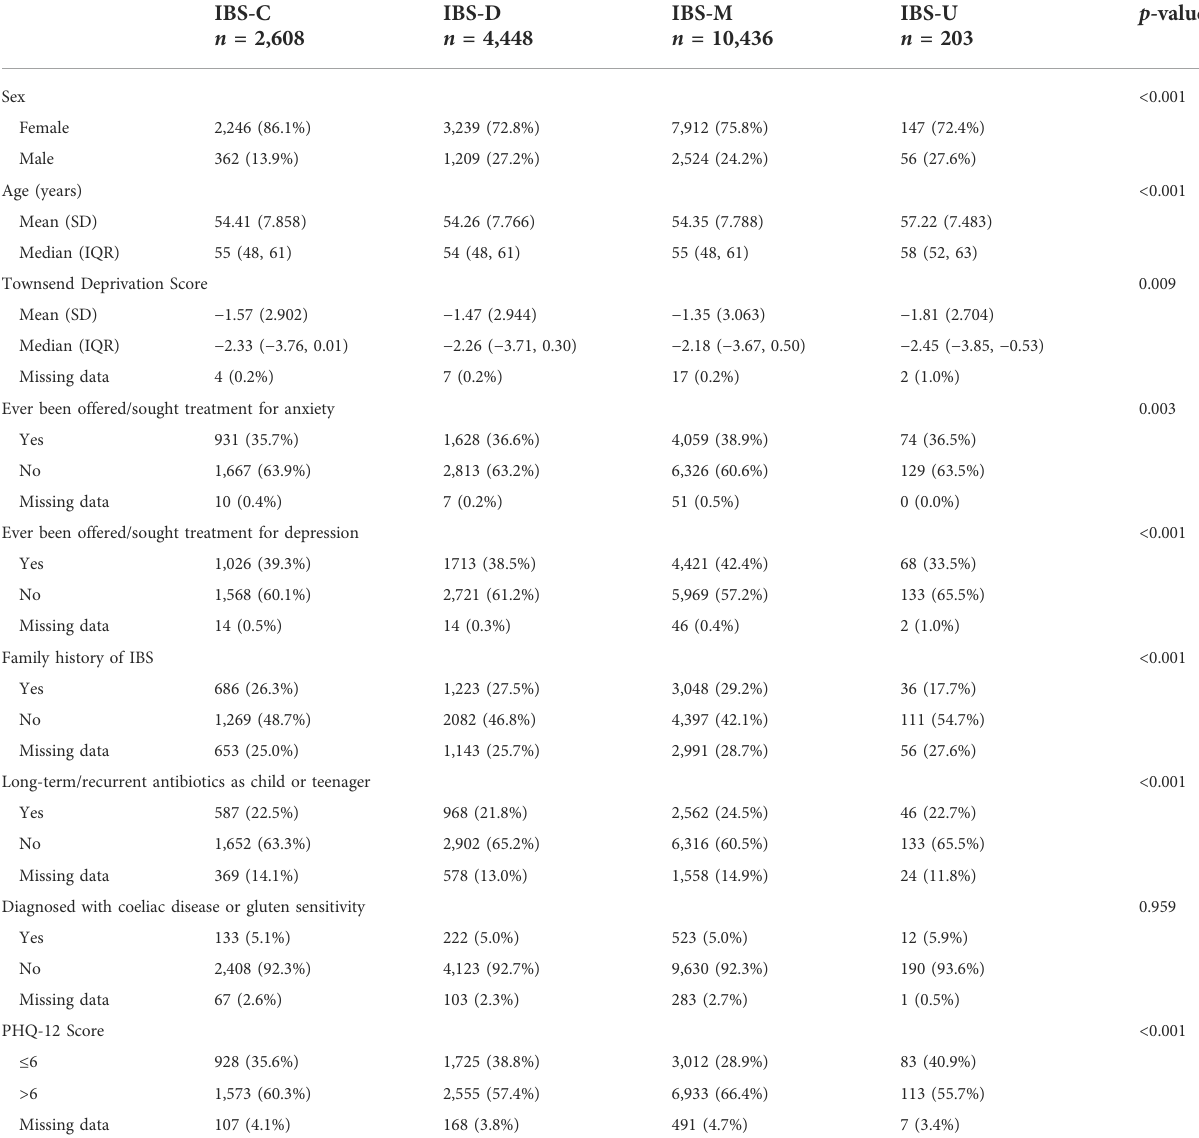
TABLE 2 Chi-square analysis of differences in in fl uencing factors among different subtypes ( n = 17,695).